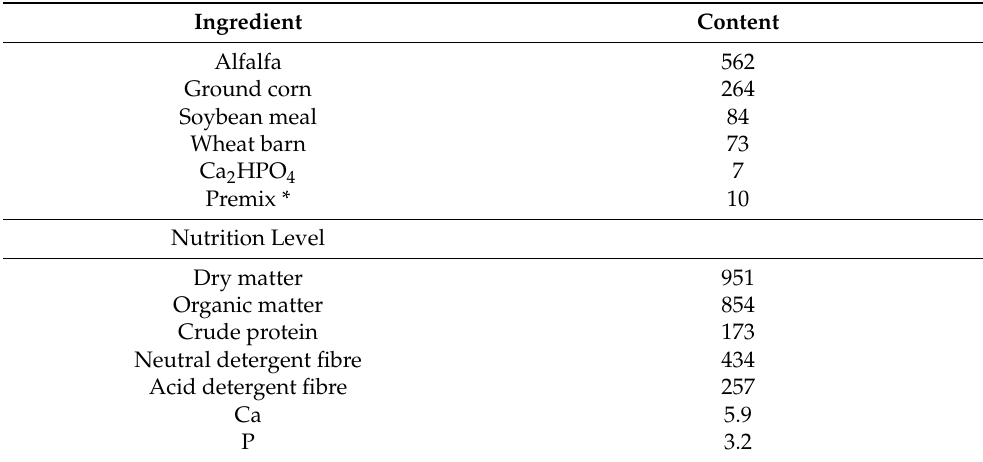
Table 1. Ingredients and nutrition (g/kg) of the basic diet fed to the goats.